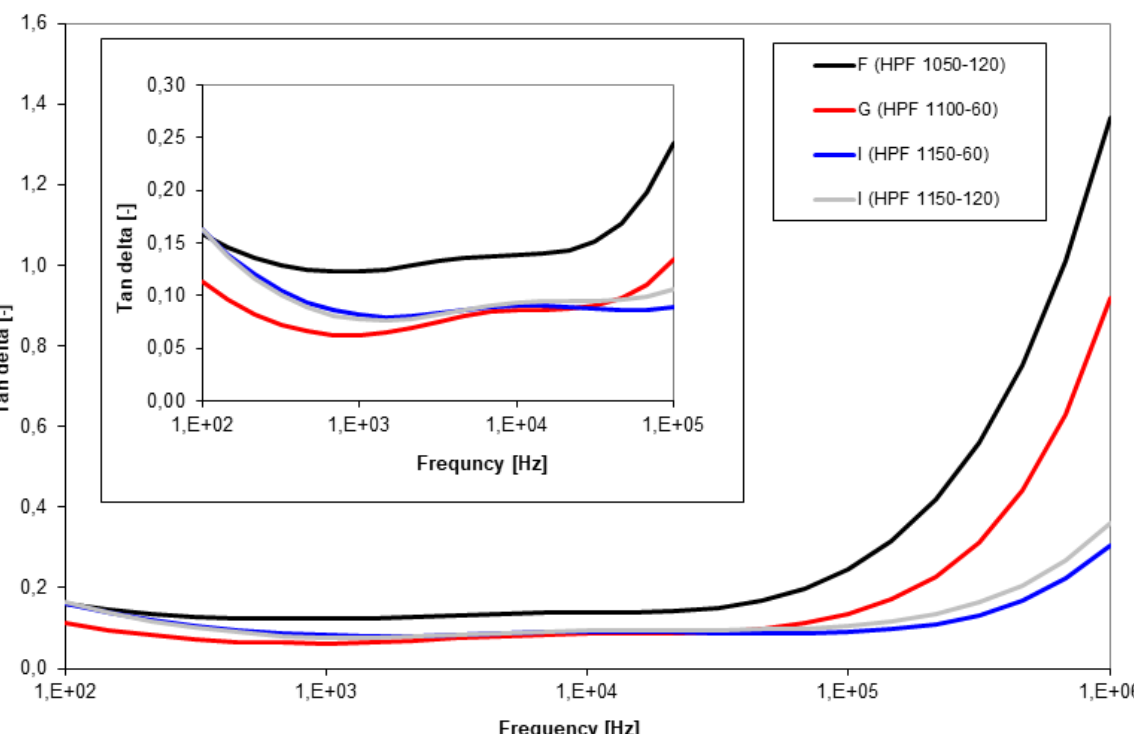
Figure 10. Relative permittivity of four HPF samples (measured at room temperature).